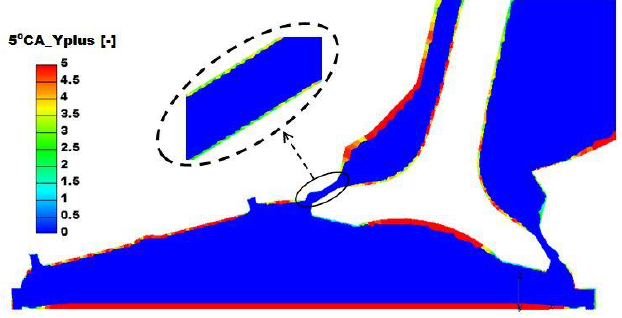
Figure 8. The y + dimensionless wall normal distance at the intake valve gap.